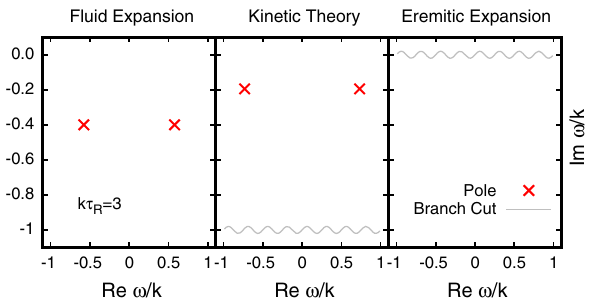
Fig. 1 Collectivesoundmodestructureinthecomplexfrequencyplane for kinetic theory in the relaxation time approximation (middle panel), small mean free path (fluid) expansion (left panel) and large mean free path (hermit) expansion (right panel). Simple poles of the retarded cor- relator are shown as crosses, while logarithmic branch cuts are shown as